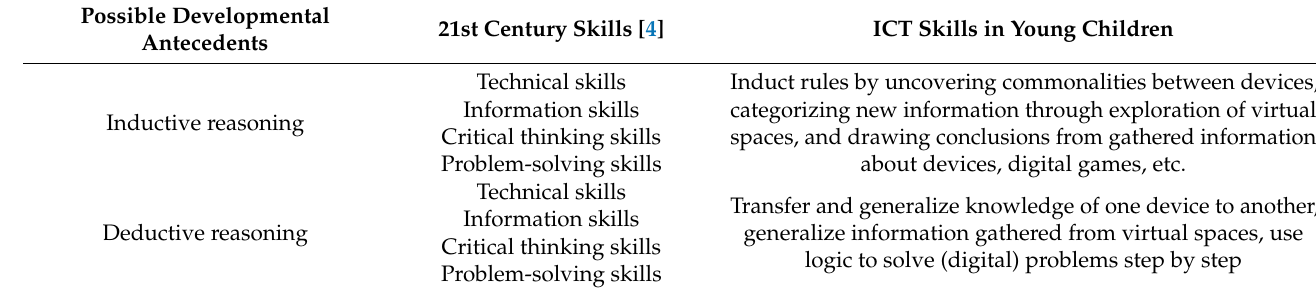
Table 1. 21st century skills and their possible developmental